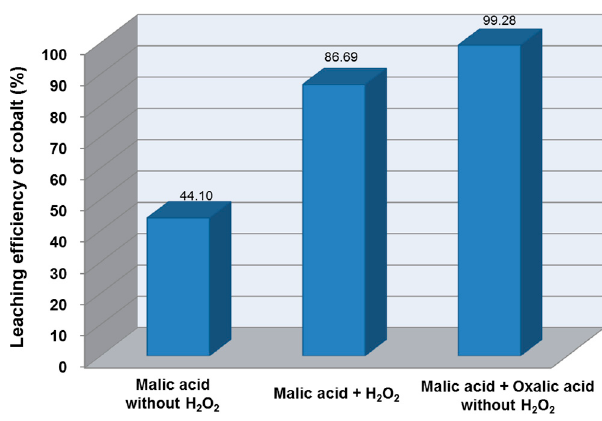
Figure 5. Cobalt leaching efficiency of malic acid with H 2 O 2 or oxalic acid.